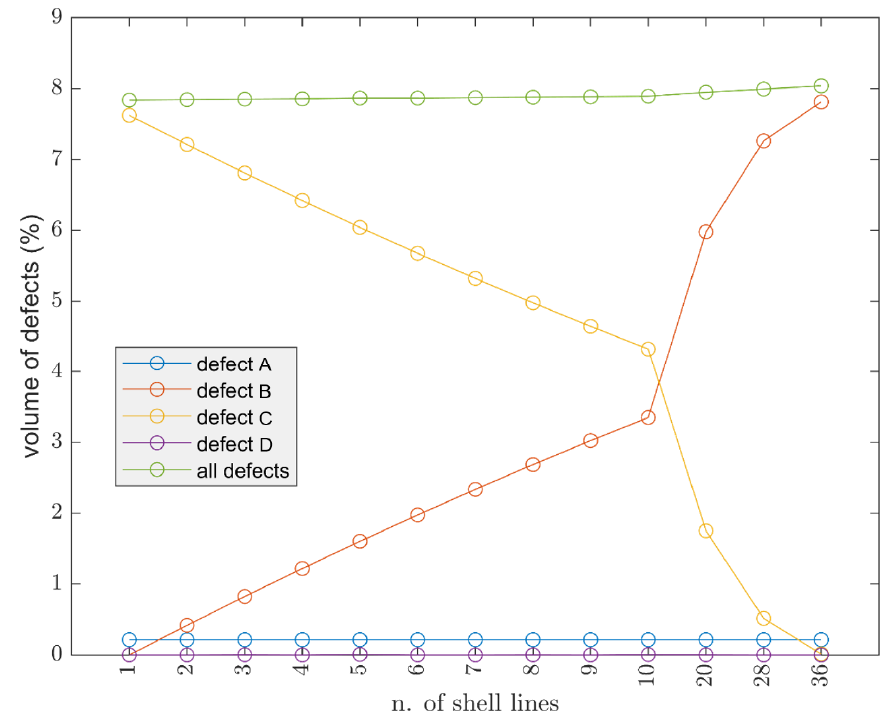
Figure 8. Influence of the number of shell (contour) lines on 30 × 30 × 30 mm cube, nozzle 0.4 mm, line width 0.4 mm, layer height 0.15 mm, raster angle 45°.